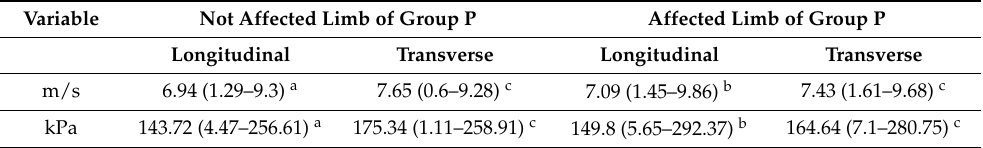
Table 4. Velocity (m/s) and Young’s modulus (kPa) in the unaffected limb and affected limb of Group P. Values are expressed as median and range. Statistical significance was set at p < 0.05. Variable Not Affected Limb of Group P Affected Limb of Group P Longitudinal